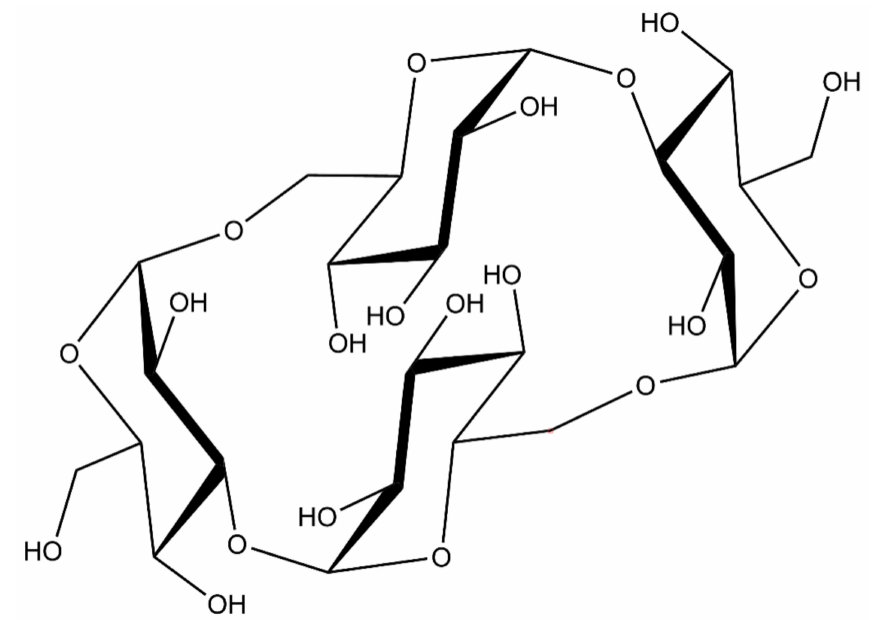
Figure 1. The structure of cyclic nigerosyl-nigerose